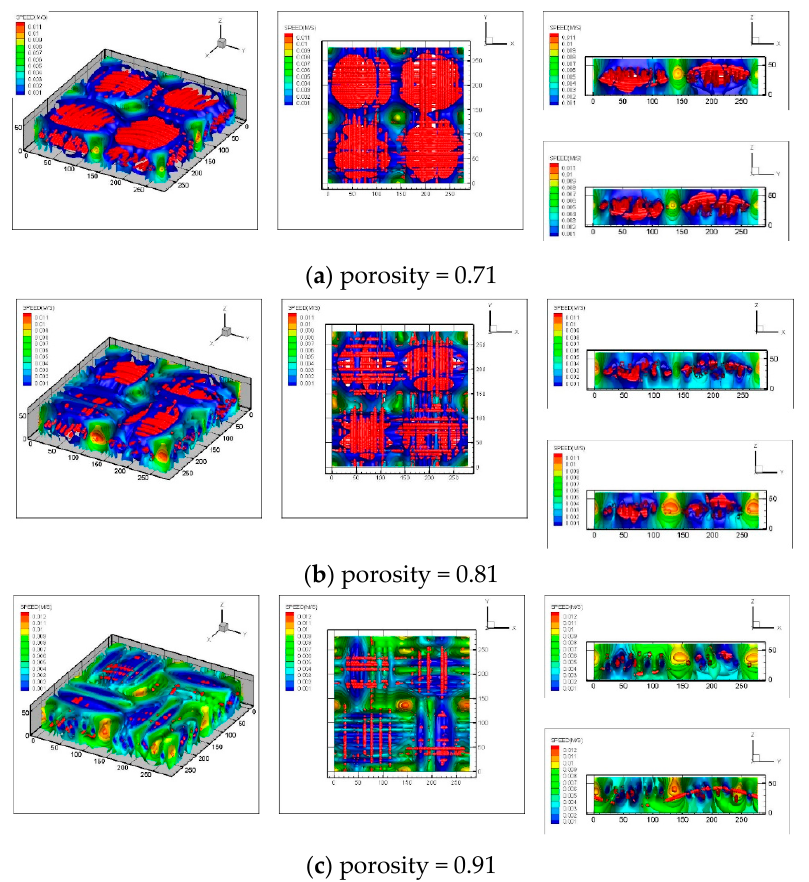
Figure 11. ( a – c ) The simulated velocity fields of carbon cloth GDLs with different porosities. (fiber radius = 3 μ m). ( a ) porosity = 0.71 ( b ) porosity = 0.81 ( c ) porosity = 0.91.